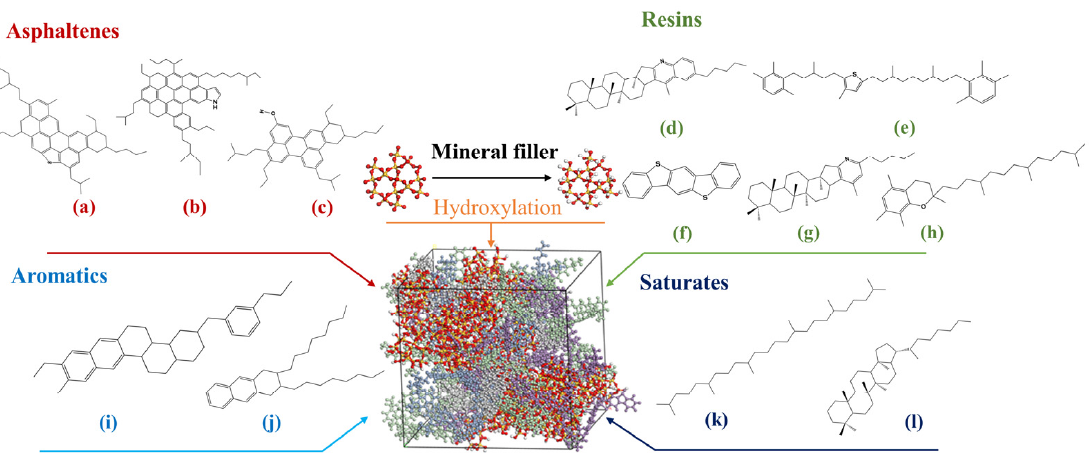
Figure 1. Molecular structures used in the 4-component model of asphalt. Asphaltenes: ( a ) Thiophene, ( b ) Pyrrole, ( c ) Phenol; Resins: ( d ) Quinolinohopane, ( e ) Thio-isorenieratane, ( f ) Benzobisbenzothiophene, ( g ) Pyridinohopane, ( h ) Trimethylbenzene-oxane; Aromatics: ( i ) PHPN, ( j ) DOCHN; Saturates: ( k ) Squalane, ( l ) Hopane.